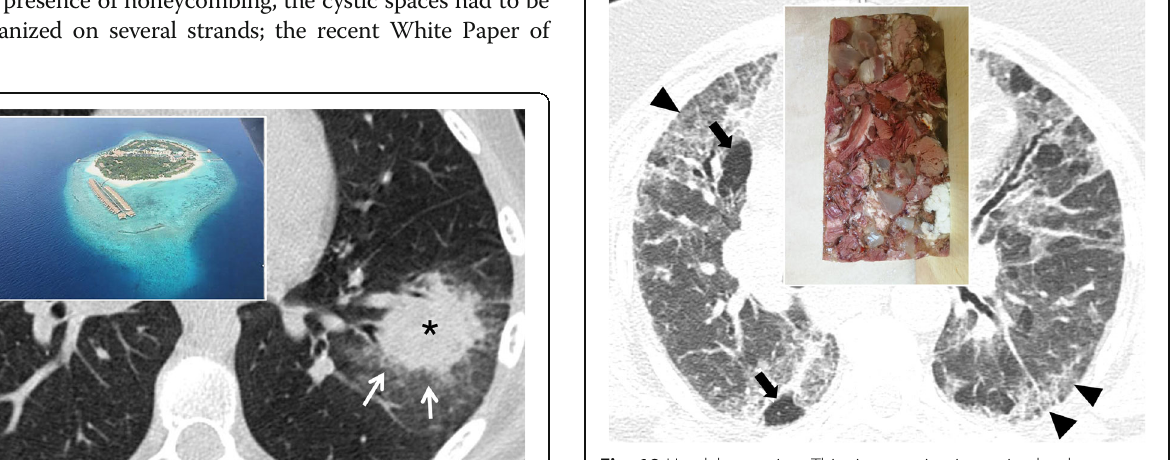
Fig. 19 Headcheese sign. This sign consists in a mixed pulmonary pattern with areas of various attenuation. It is characterized by the contemporary presence of areas of ground glass attenuation (black peripheral arrowheads, due to infiltrative diseases), air-trapping (black arrows), and healthy lung zones. This pattern is reminiscent of the appearance of headcheese — as well demonstrated in this patient with subacute hypersensitivity